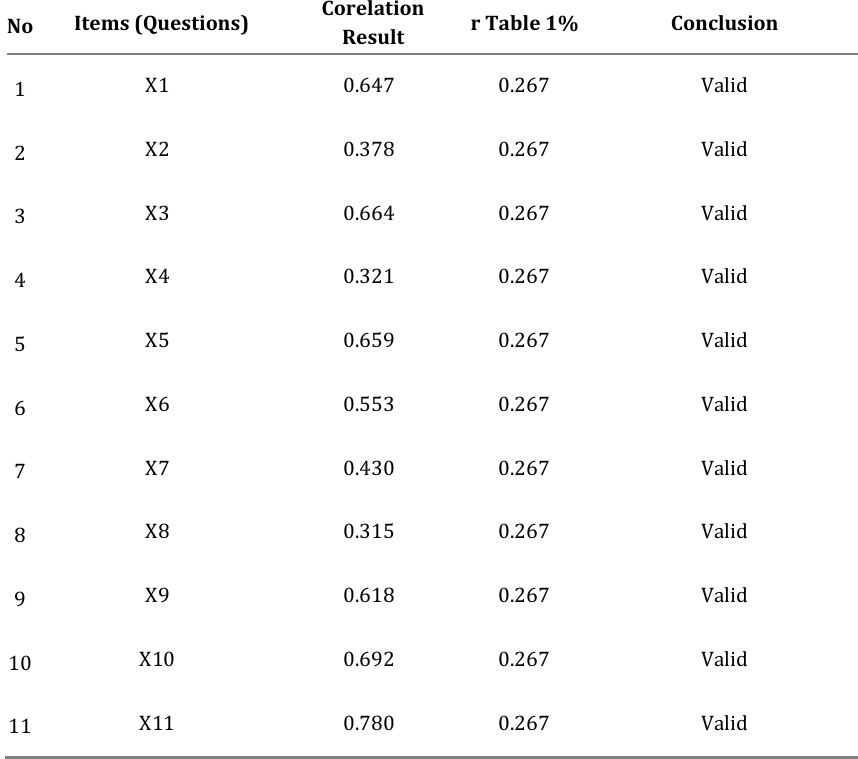
Table 2 Instrument Validity Result Test Islamic Understanding (Y